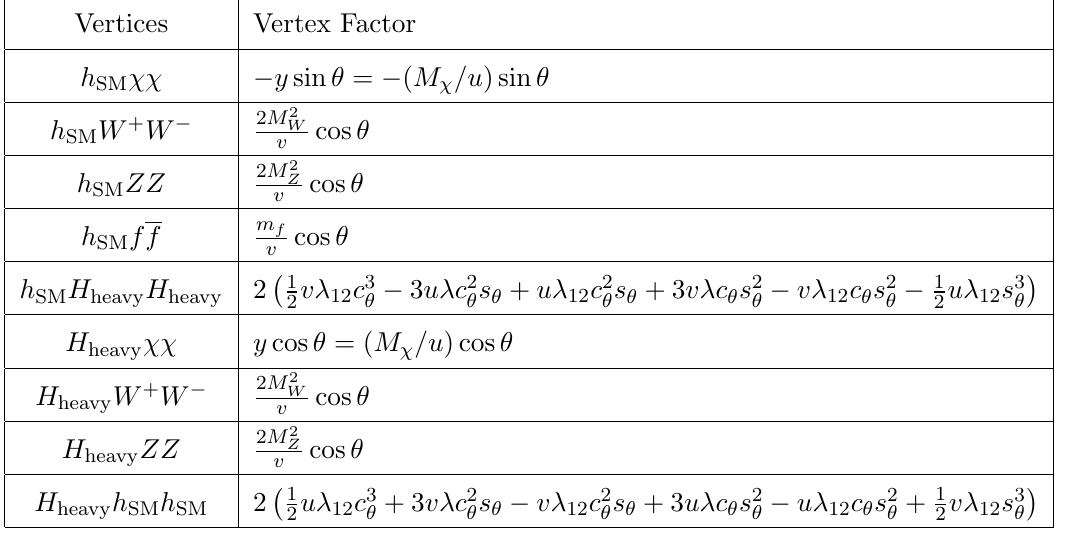
Table 5 . Relevant vertices implying DM-SM interactions with vertex factors for high mass